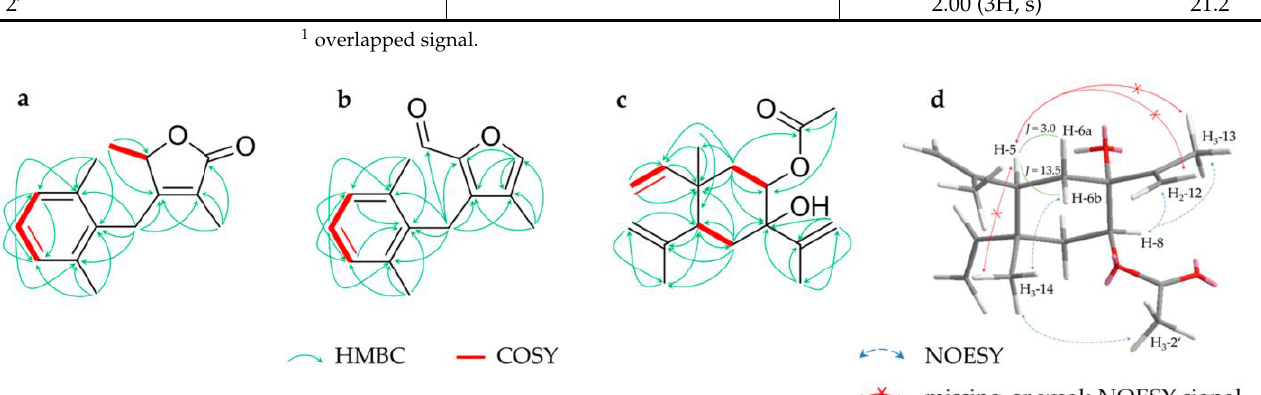
Figure 2. Key HMBC and COSY correlations for compounds 1 ( a ), 2 ( b ) and 3 ( c ) and relevant (or missing) NOESY signals for compound 3 ( d ); J in Hz.